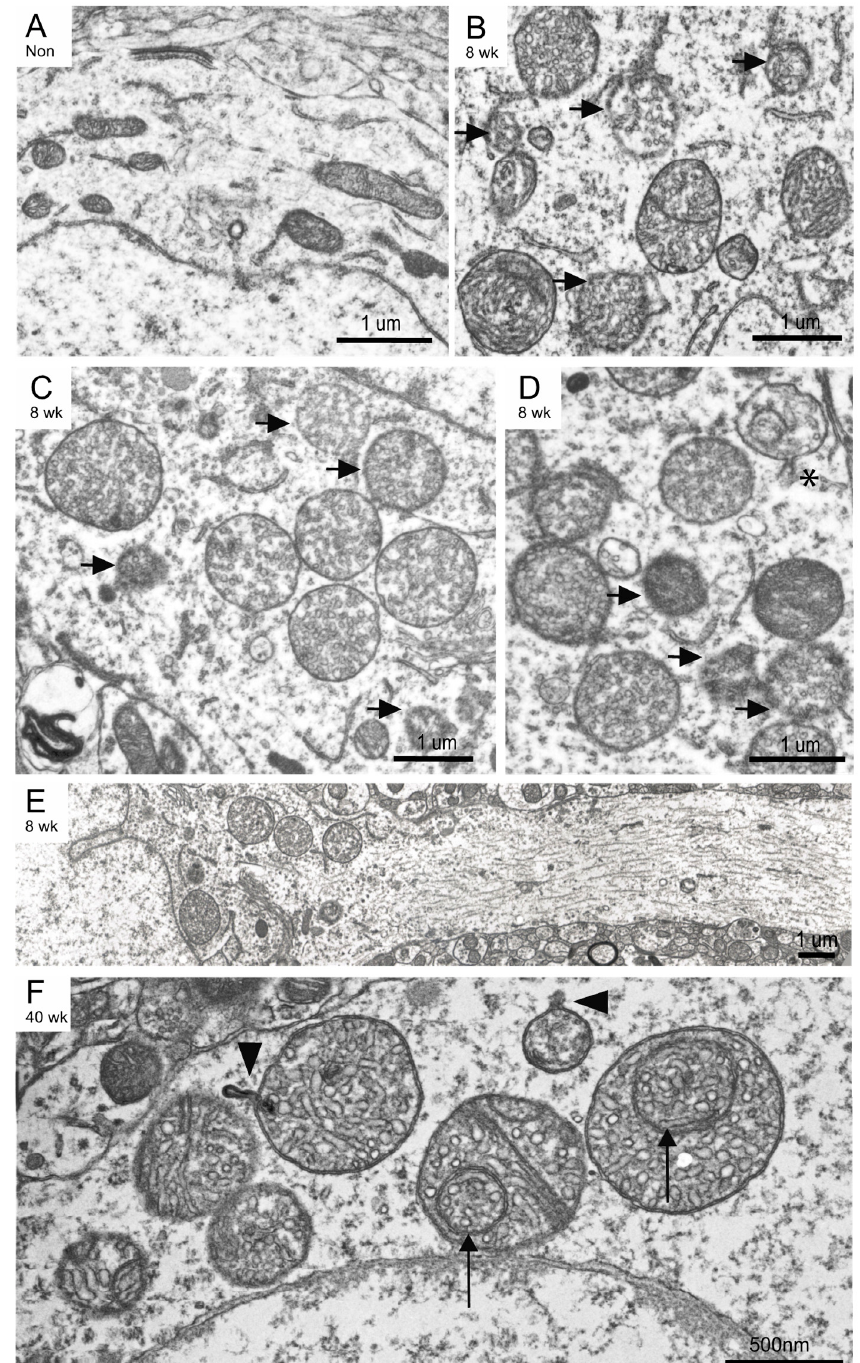
Figure 4. Other ultrastructural defects included cristae and membrane degeneration. Mitochondria abnormalities in the 8 weeks post-induction Mfn2KO neurons included degenerating outer membranes (arrows) and small circular cristae ( B – D ), which are compared with normal tubular mitochondria with intact cristae from a non-induced mouse with the same genotype shown at the same magnification ( A ). Some mitochondria have a ruptured outer membrane (( D ), *). In the Mfn2KO mice neurons, mitochondria were often clustered only in the soma, with few to none present along the processes ( E ), resembling the immunostaining pattern shown in Figure 2. At 40 weeks post-induction, the remaining neurons had mitochondria with internal circular cristae and compartmentalization (( F ), arrows), and some mitochondria had protrusions (( F ), arrowheads).